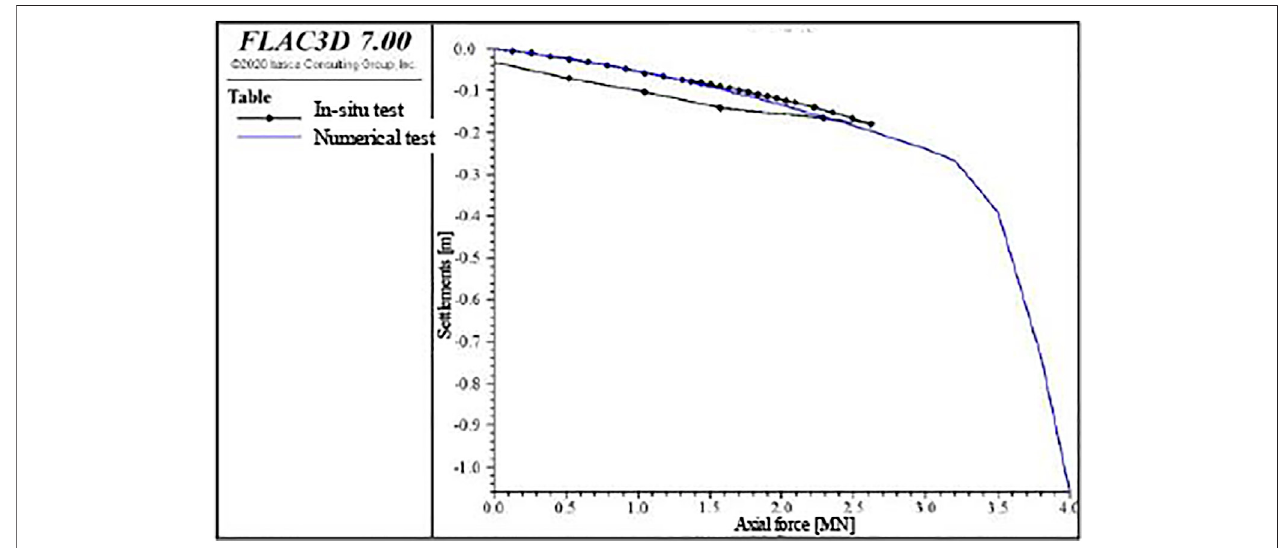
FIGURE 5 | Numerically calculated Q-S curve compared to measured Q-S curve of PHC pile.